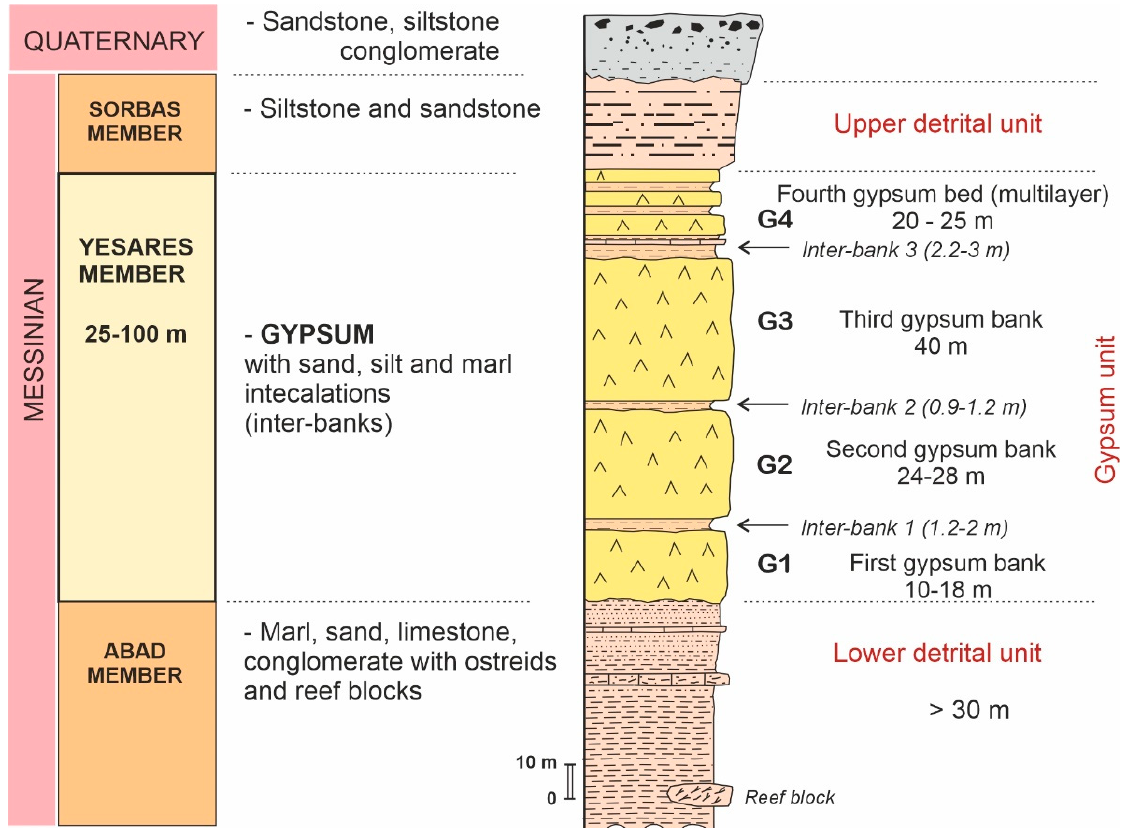
Figure 4. Stratigraphy of the study area, where four banks (G1, G2, G3, and G4) are differentiated within the gypsum unit (Yesares Member) separated by three detrital beds, mainly of fine sand, which are denominated as inter-banks.